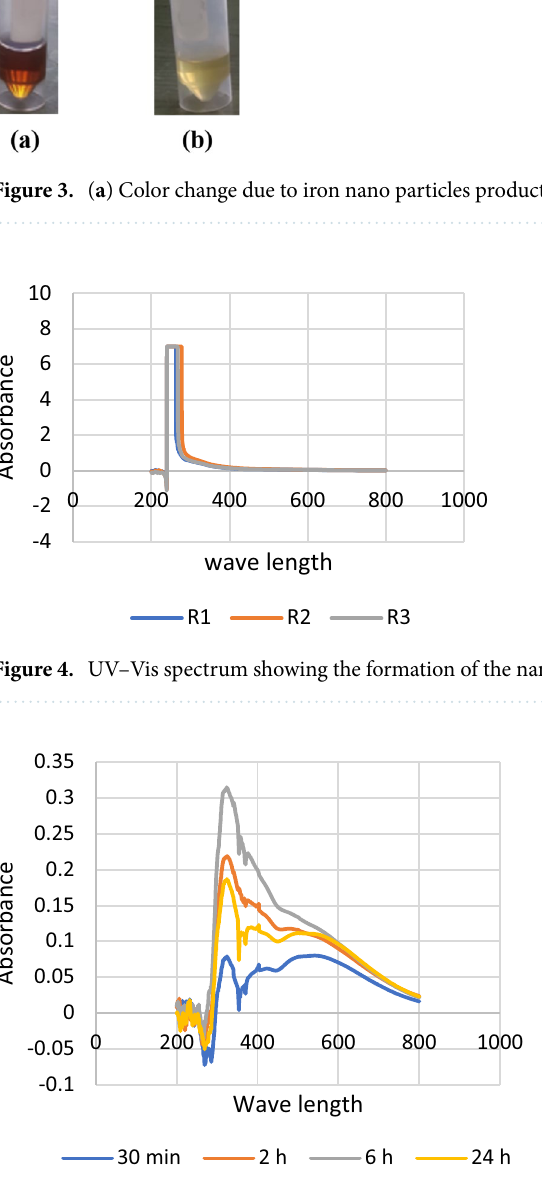
Figure 5. UV–Vis spectrum for tracking nano iron synthesis over different time